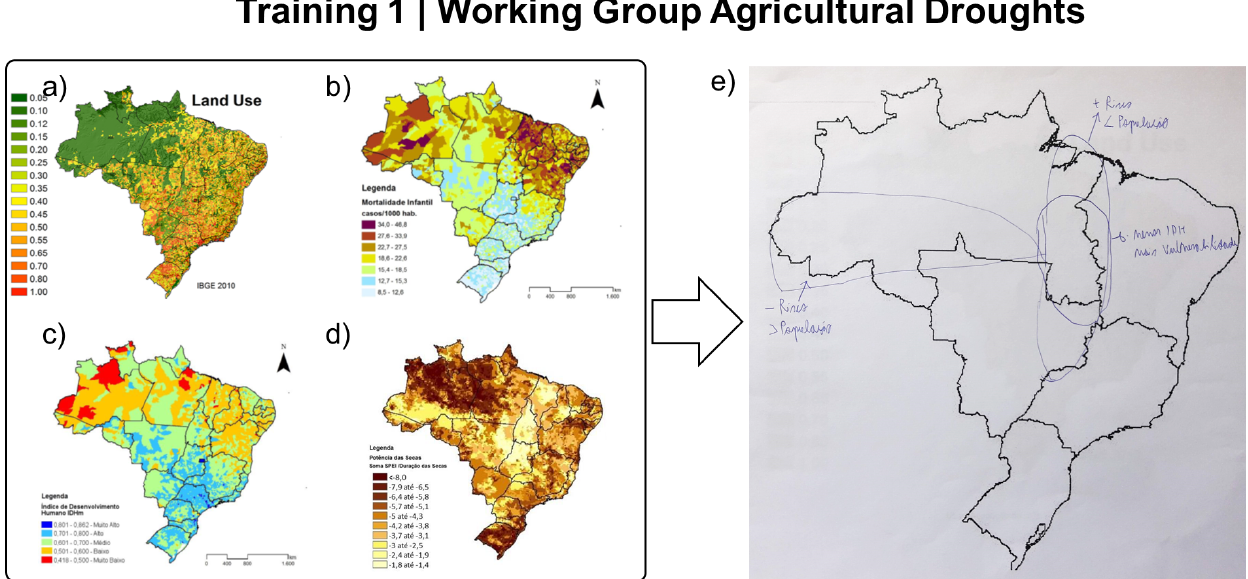
Figure A4. Package of maps used in the first training for mapping climate risk associated with agricultural droughts. The maps illustrate (a) land use (MMA, 2017), (b) child mortality (MMA, 2017), (c) Human Development Index (HDI; MMA, 2017), (d) drought potential (MMA, 2017), and (e) the climate risk map drawn by the